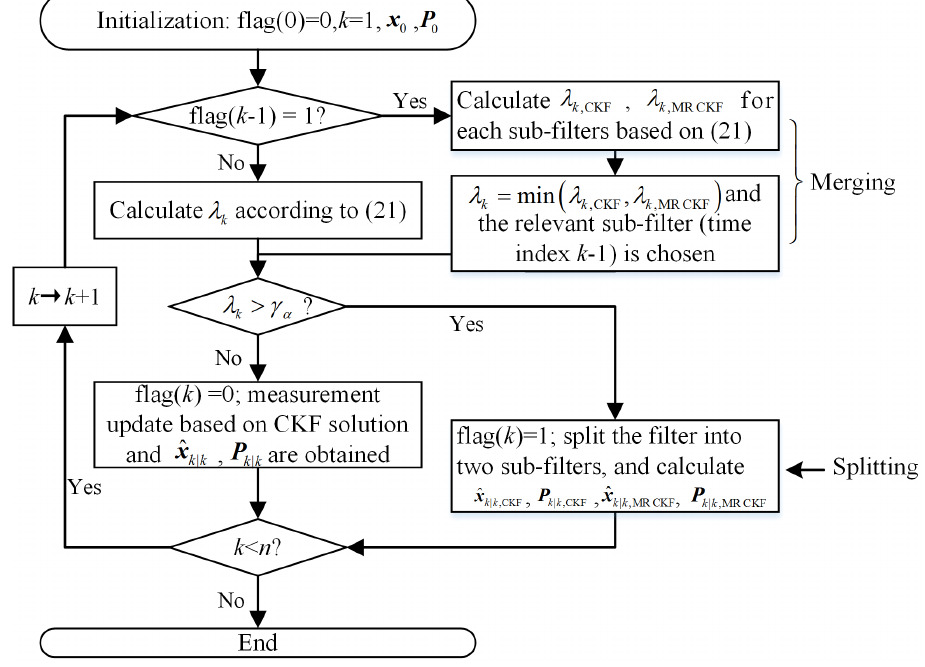
Figure 1. The flow diagram of the FMR-CKF.